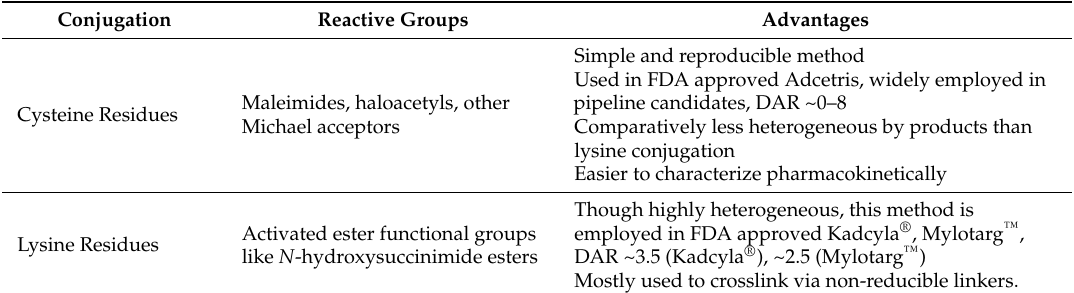
Table 1. Comparison between different side chain conjugation